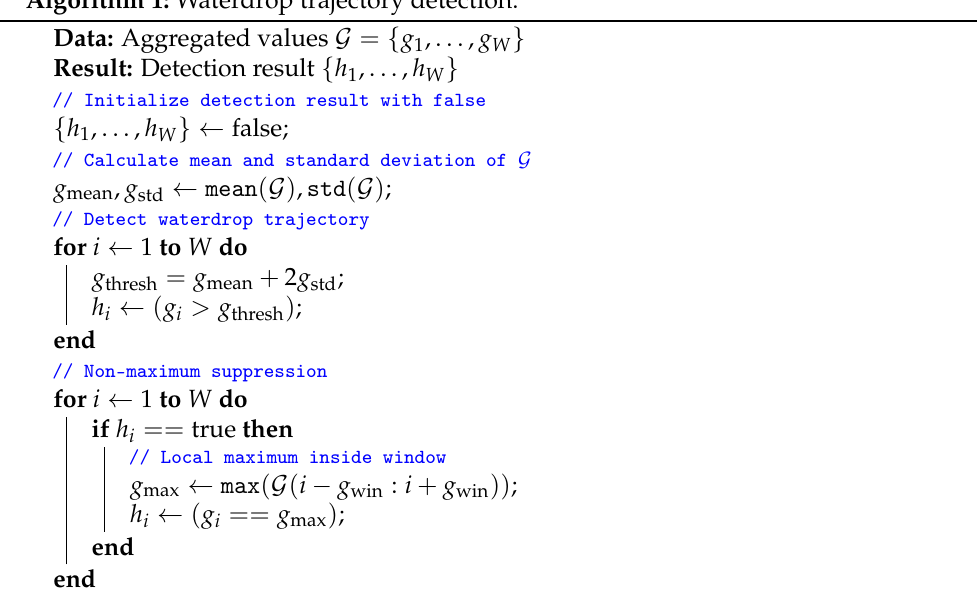
Algorithm 1: Waterdrop trajectory